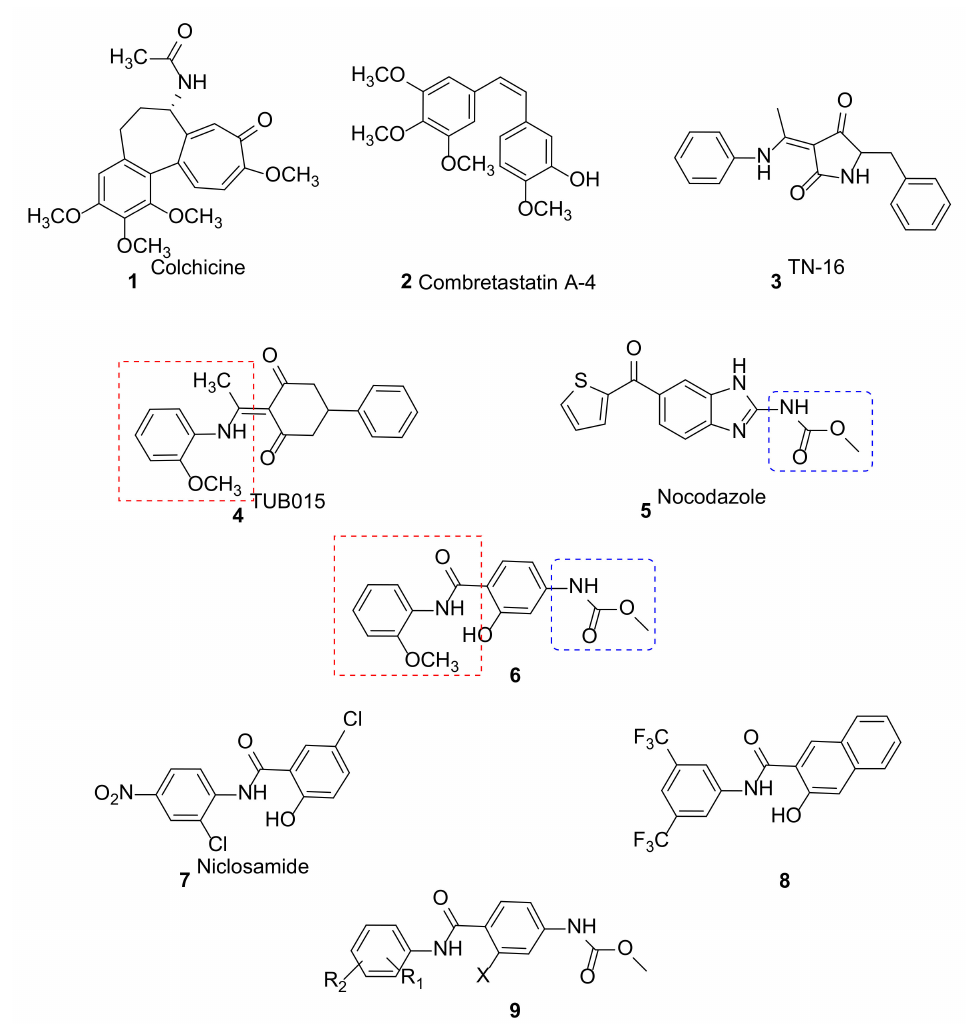
Figure 1. Chemical structures of colchicine-site binders in tubulin ( 1 – 5 ) and different salicylanilides ( 6 – 9 ) including niclosamide ( 7 ) and the here addressed compounds ( 6 , 9 ). Our group has been involved in the identification and optimization of new scaffolds that are able to bind at the colchicine site in tubulin. Performing a ligand-based virtual screening approach, using TN-16 ( 3 ) as the model compound, we identified a series of cyclohexanediones that are potent colchicine-site binders [9]. Recently, the binding mode of these cyclohexanediones [i.e., TUB015 ( 4 ), Figure 1] into the colchicine site in tubulin has been determined by X-ray diffraction [10]. As expected, the compound binds in a similar way to TN-16 into the deeper part of the β -subunit (Figure 2A). The 5-phenyl ring of the cyclohexanedione is lodged into a cavity lined by residues β Ile4, β Tyr52, β Gln136, β Phe169, β Tyr202, β Thr239, β Leu242, and β Leu252, among others, while there is a polar interaction between one of the carbonyls of the cyclohexanedione and the side chain of β Glu200. On the other hand, the 2-methoxyaniline of TUB015 is stabilized by hydrophobic interactions. Among the published structures of colchicine ligands with tubulin, nocodazole ( 5 , Figure 1) occupies the same deep pocket as TUB015, and, interestingly, it also interacts with β Glu200 (Figure 2B) [11]. Indeed, when the binding modes of TUB015 and nocodazole are superimposed, there is almost a perfect fit, as shown in Figure